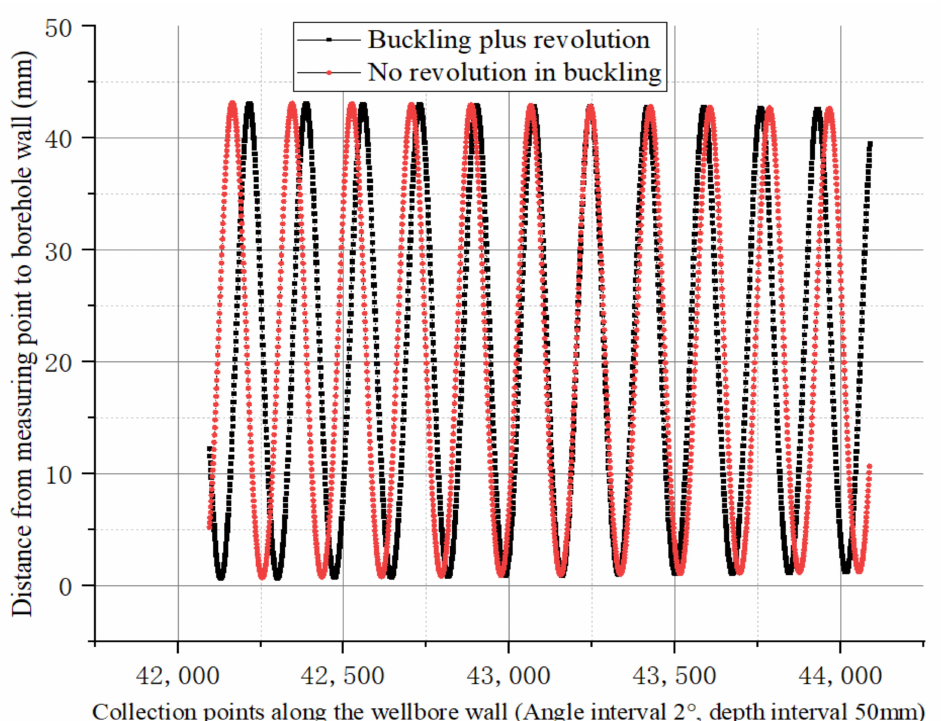
Figure 17. The phase change after additional revolution compared with that without additional